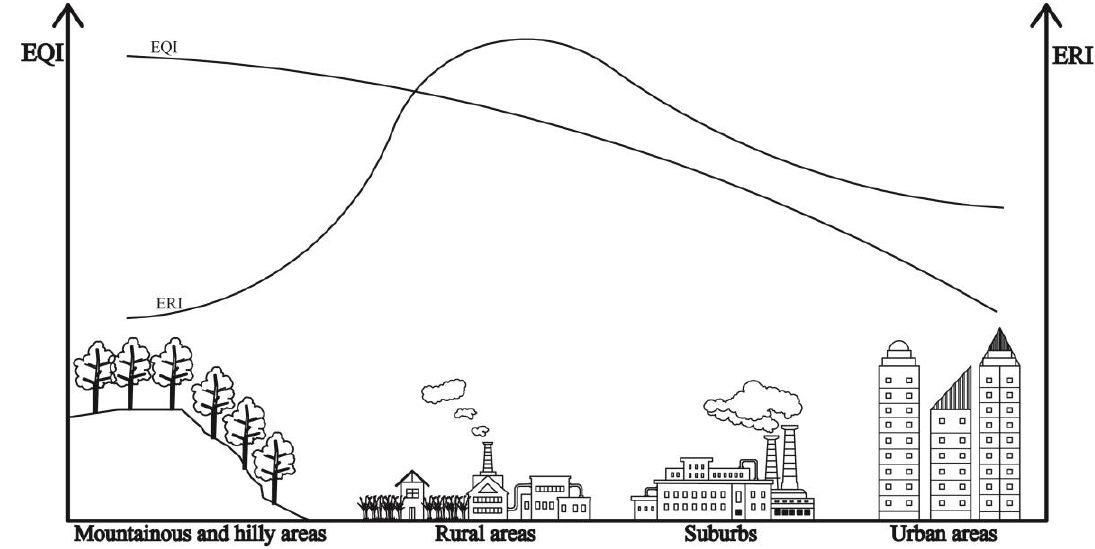
Figure 8. Spatial shift in EQI and ERI , from the regional rural to urban scale.